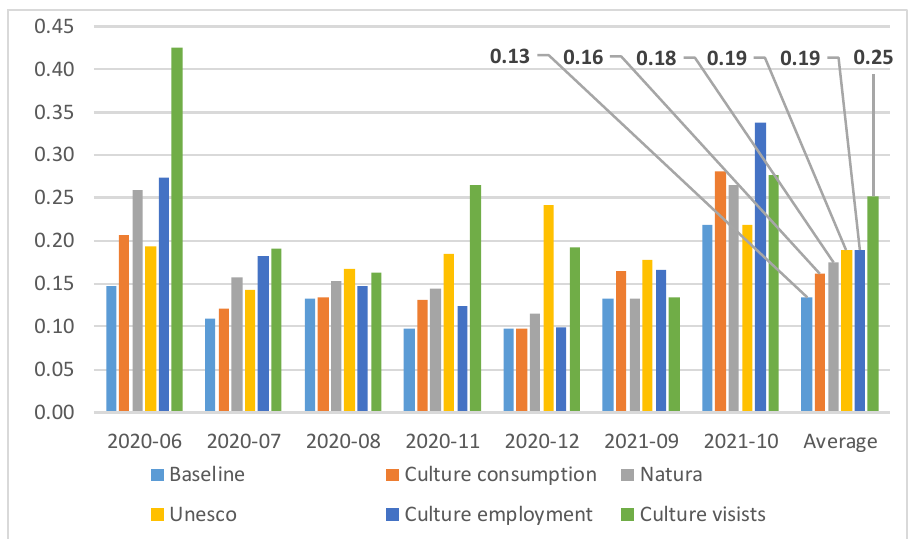
Figure 2. Coefficients of determination (R 2 ) for 7 months with at least 0.10 values in the baseline multiple regression, and further 5 regressions adding indicators of heritage and culture for the 20 countries under review. Source: Author’s calculation, using data specified in the Data Availability Statement.